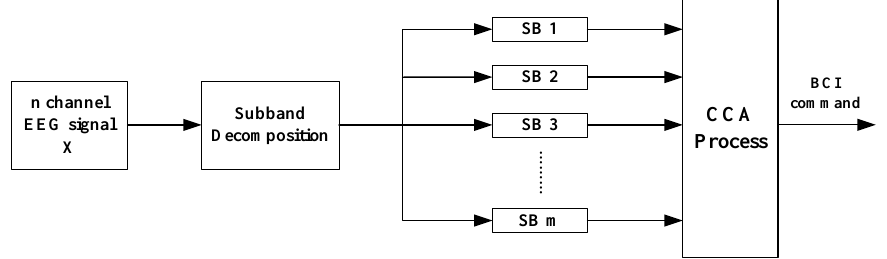
Figure 1. The process of FBCCA in EEG signal analysis.